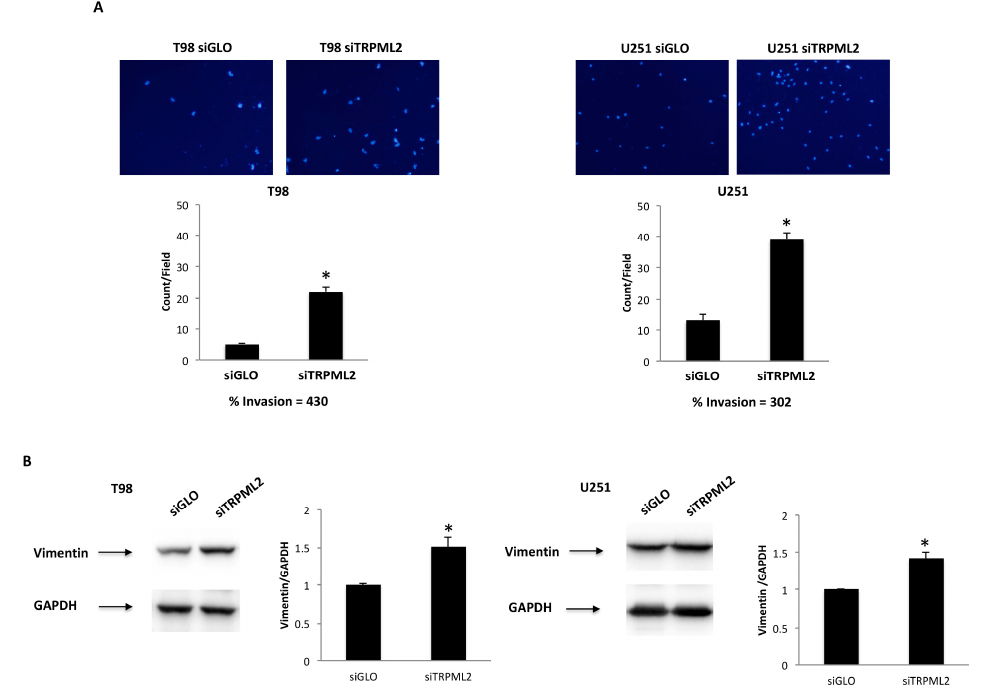
Figure 4. TRPML2 silencing increases the invasion capability in T98 and U251 cell lines. ( A ) Repre- sentative images showing DAPI fluorescence after 24 h culture in Transwell chambers ( × 10 magnifi- cation). The siGLO and siTRPML2 T98 and U251 invading cells were counted in 10 randomly chosen microscopic fields per transwell. Each sample was run in triplicate, and three independent experi- ments were performed. Bars represent the quantification of invaded cells in each field (Mean ± SE), * p < 0.01. ( B ) Representative immunoblots reflecting vimentin protein levels in siGLO and siTRPML2 T98 and U251 cell lines. Blots are representative of one of three separate experiments. Densitometry values were normalized to GAPDH, which was used as a loading control. Data are expressed as the mean ± SE of three separate experiments. * p < 0.05.